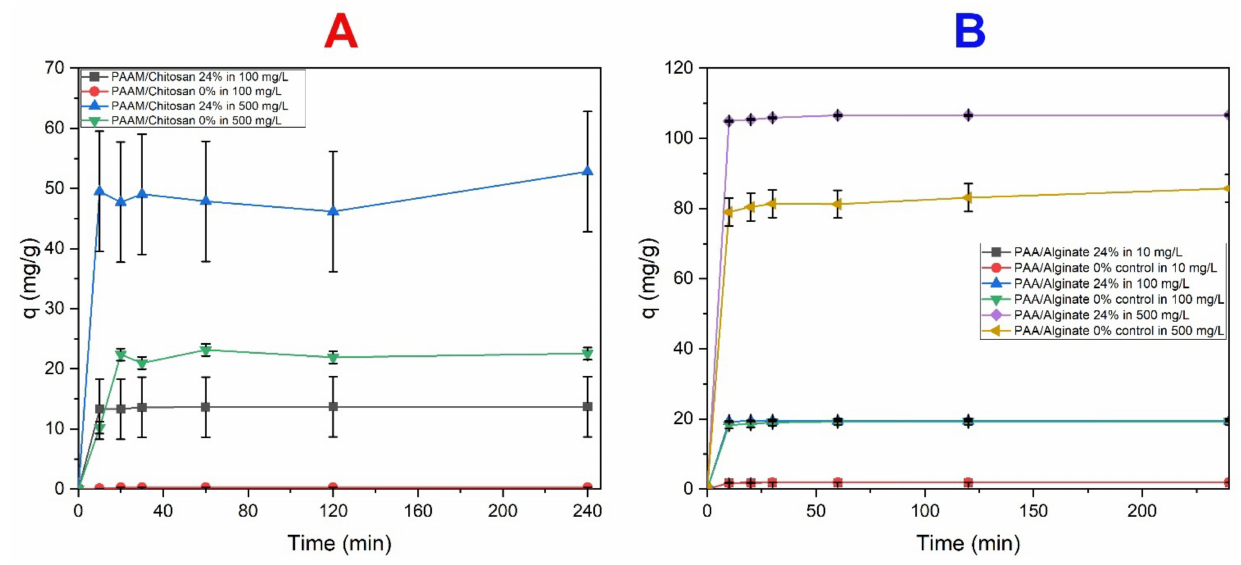
Figure 10. The effect of interaction time on the adsorption capacity using different dye concentra- tions. ( A ) Adsorption time of PAAM/chitosan (0.05 g) adsorbing MO (100, 500 mg/L) at pH = 3. ( B ) Adsorption time of PAA/Alginate (0.05 g) adsorbing MB (10,100, and 500 mg/L) at pH = 8.5.